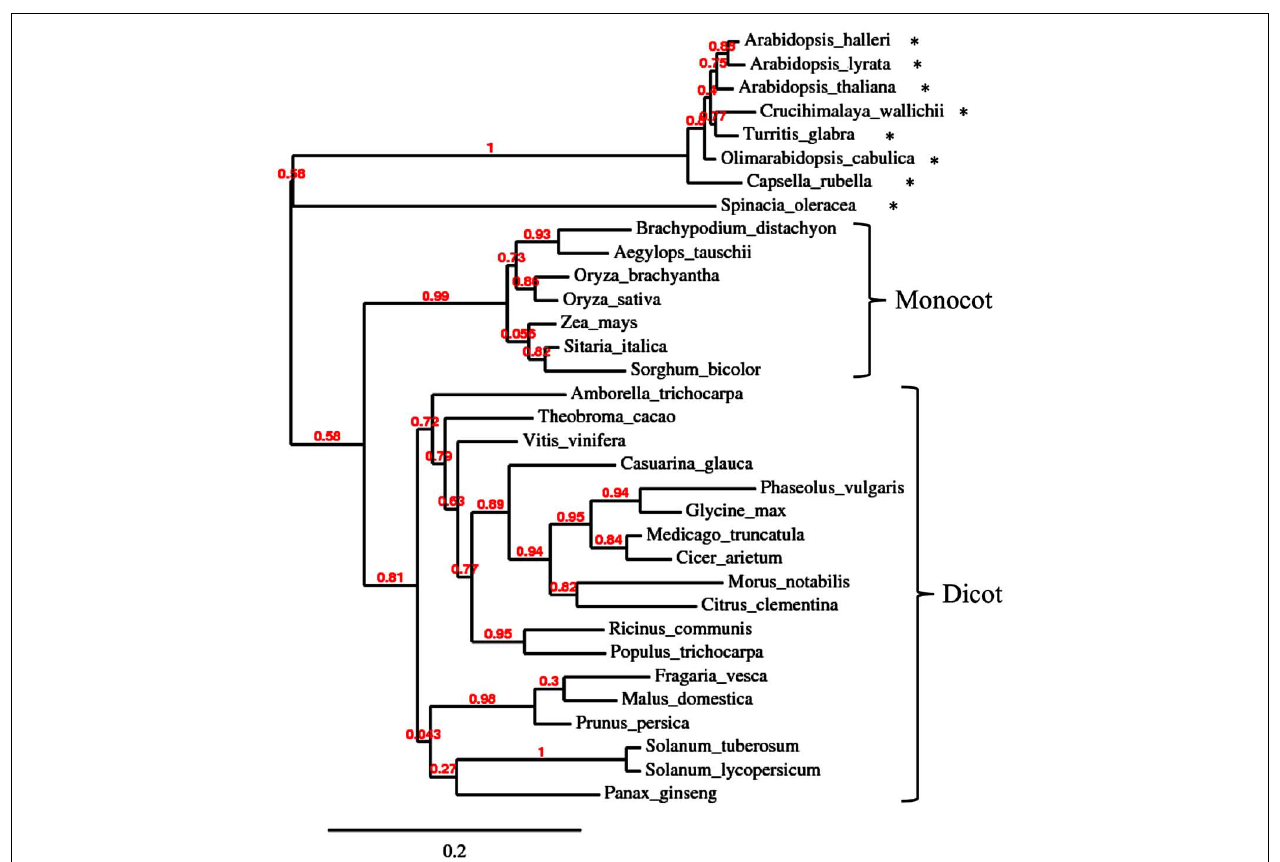
FIGURE 4 | Phylogenetic analysis of type III chitinase in higher plants. Unrooted phylogenetic tree of chitinase type III of various angiosperm species. Protein sequences were retrieved by pblast from NCBI using Medicago truncatula chitinase III-3 (AY238969.1) as query. For each species,